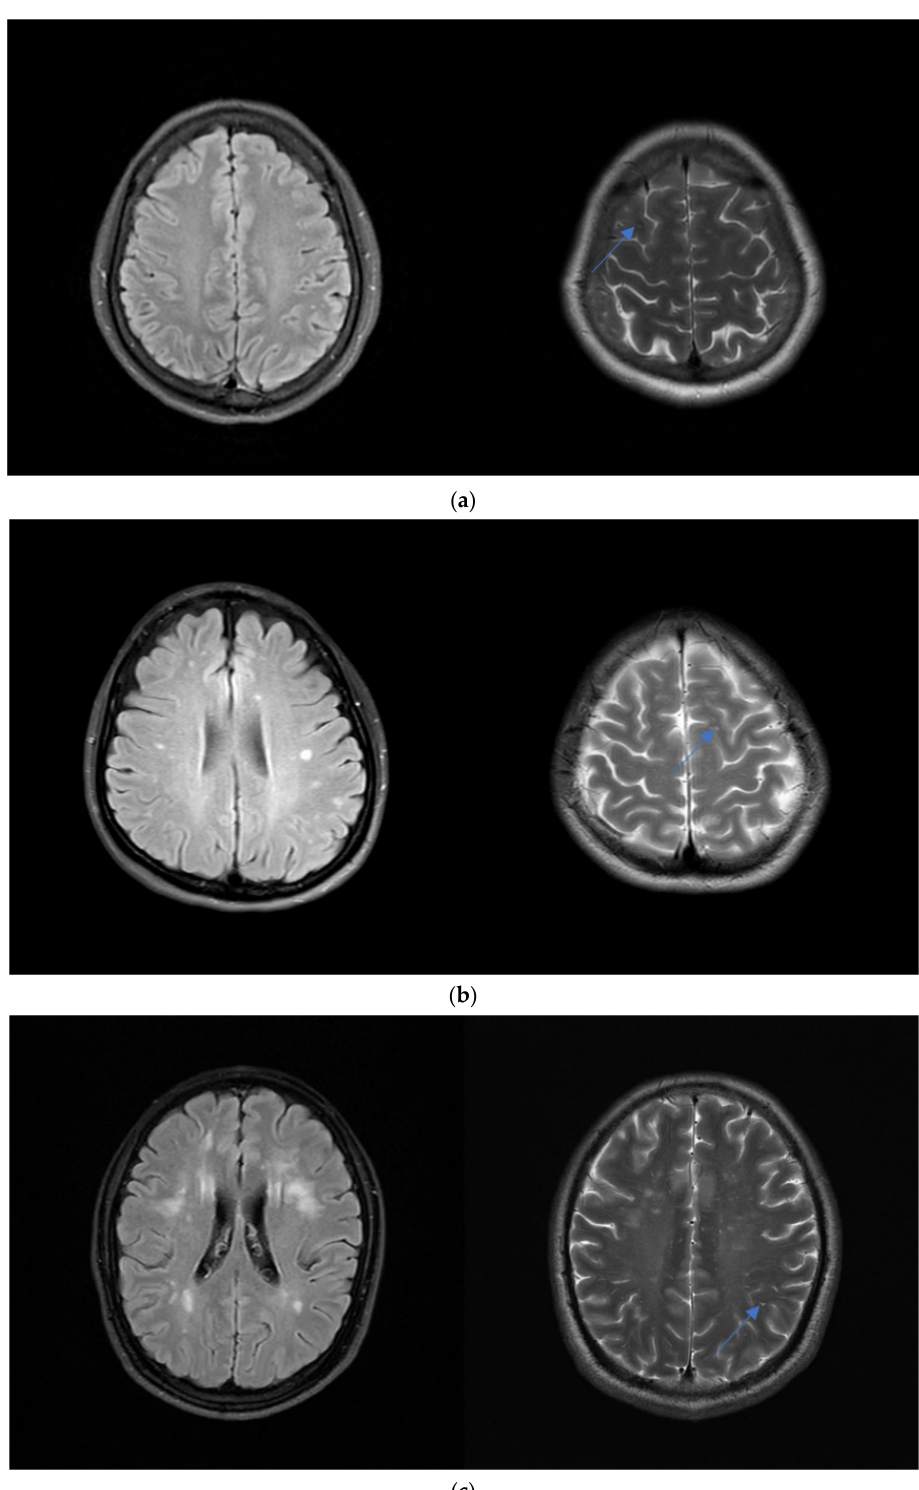
Figure 2. Levels of the severity of WMH. ( a ) A 23-year-old woman with a headache. Axial FLAIR MR images show mild DWMH. Axial T2-weighted images show grade 1 CSO-ePVS (blue arrow). ( b ) A 36-year-old woman with dizziness. Axial FLAIR MR images show moderate DWMH. Axial T2-weighted images show grade 2 CSO-ePVS (blue arrow). ( c ) A 45-year-old man with visual disturbance. Axial FLAIR MR images show severe DWMH. Axial T2-weighted images show grade 3 CSO-ePVS (blue